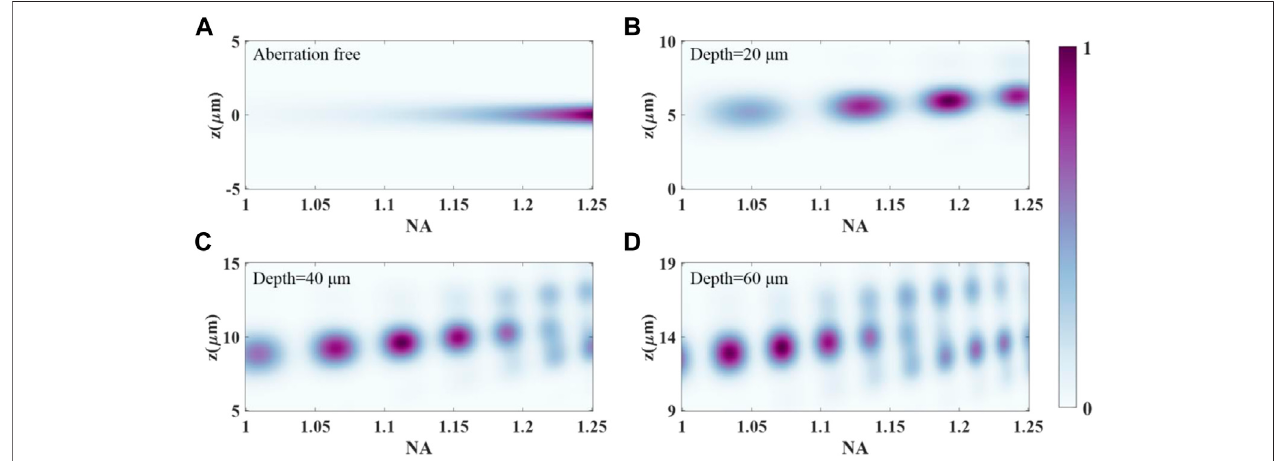
FIGURE 4 | (A) Schematic of an FDTD simulation for nonlinear microscopy for under circular polarized excitations to a vertical interface. (B) Simpli fi ed simulation geometryandpropertiesofthesimulationmaterials. (C1 – C3) Near-focusexcitation intensitydistributionsalongaverticalinterfacelocatednearthefocusforleft-handed circularpolarized beams. (C4) Theintensity linepro fi lesalongthehorizontal lines in (C1) . (D1,D2) TheSHG signalresponsedistribution toaverticalKTP – waterinterface and corresponding intensity line pro fi le. Scale bar, 1 μ m.